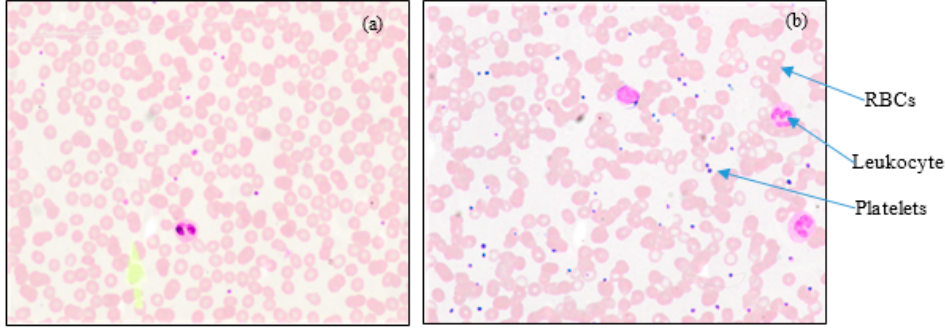
Figure 1. 40x digital microscopic PBS images: ( a ) Dengue (few platelets), and ( b ) Normal. (Courtesy: KMC, Manipal).